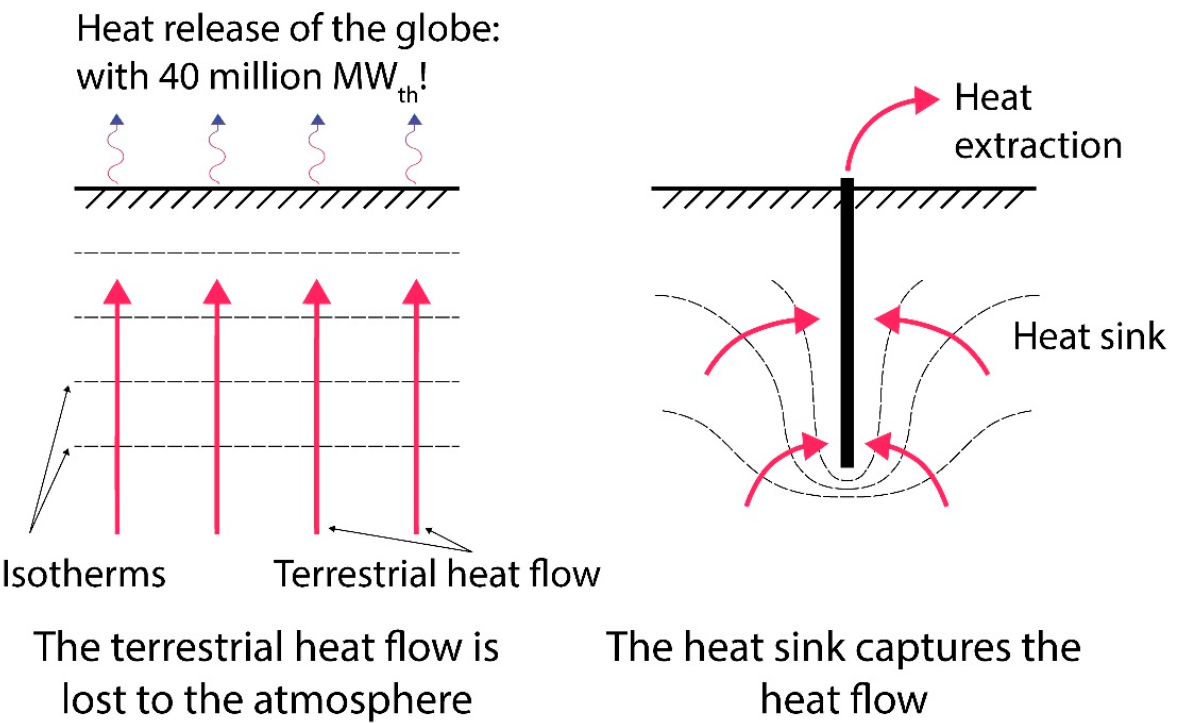
Figure 11. Schematic illustration of the principle of geothermal heat extraction and production. Arrows indicate direction of heat flow. The left panel refers to a scheme without heat extraction: The isotherms are horizontal; the terrestrial heat escapes to the atmosphere (globally with 40 × 10 6 MW th ). The right panel refers to a scheme where heat inflow replenishes the heat sink, created by the heat extraction. In this case, the isotherms are increasingly deformed and the heat flow lines are diverted towards the heat sink. Figure from [1], modified.